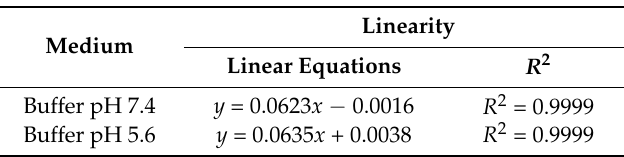
Table 1. Parameters evaluated during the standardisation of the methodology to quantify levels of ketoprofen (KTP) through UV-Visible spectrometry.